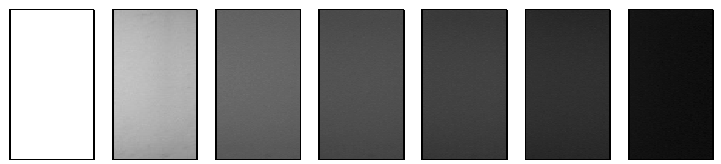
Figure 4. Shades of grey for Type1 sediment. Table 3. Step-by-step sediment addition and sediment concentration